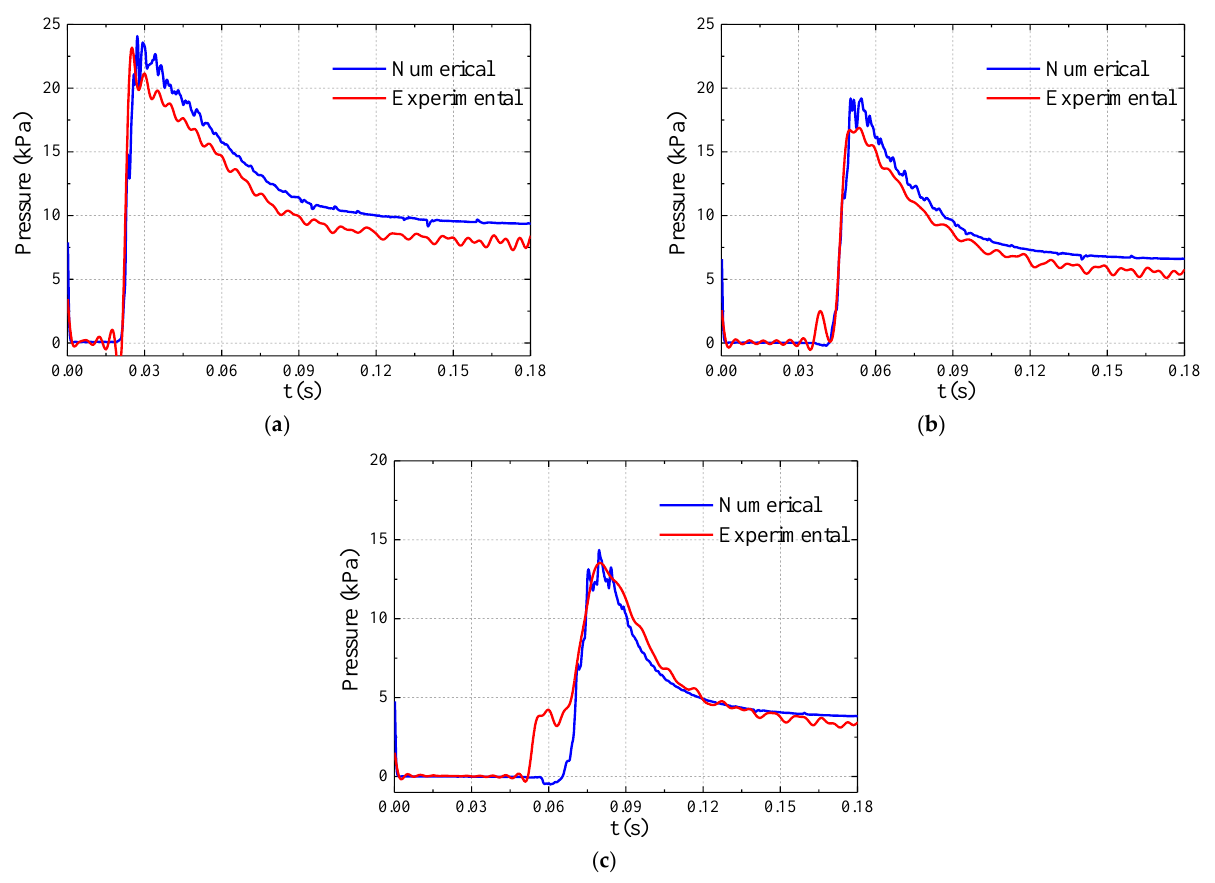
Figure 19. Comparison of impact pressure by simulation and experiment (Case 4): ( a ) impact pressure at P1; ( b ) impact pressure at P3; ( c ) impact pressure at P5.